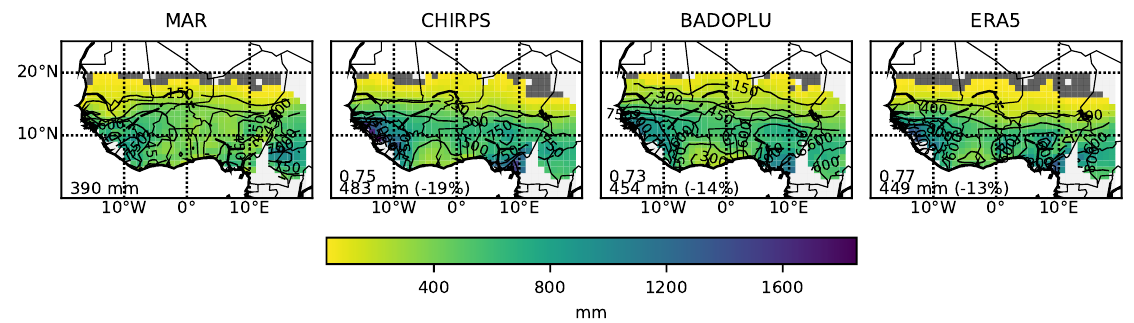
Figure A1. As in Figure 2 but for the T01 sensitivity